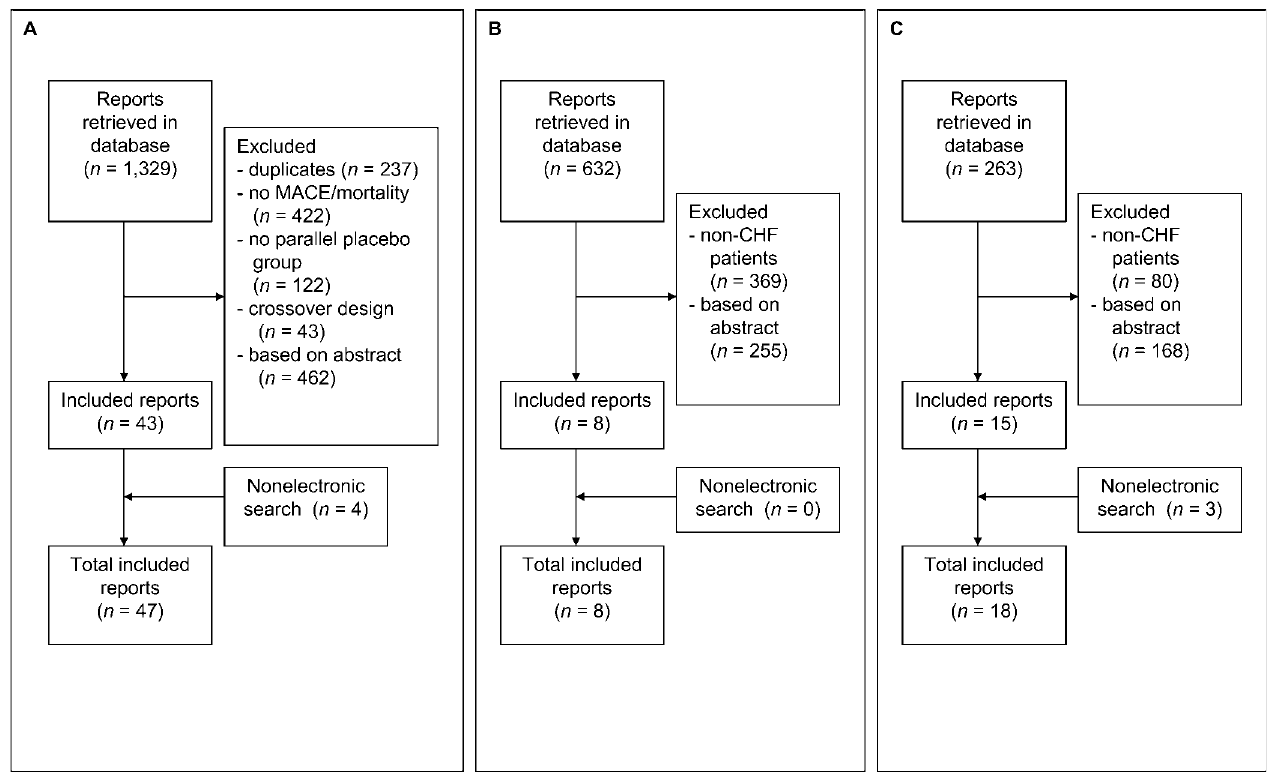
Figure 1. Flow Diagrams of Study Selection (A) Selection of studies about the handling of CHF patients in placebo-controlled statin trials. B) Selection of studies about the association between cholesterol levels and mortality in CHF patients. (C) Selection of studies containing original data on statin treatment in patients with established CHF. DOI: 10.1371/journal.pmed.0030333.g001